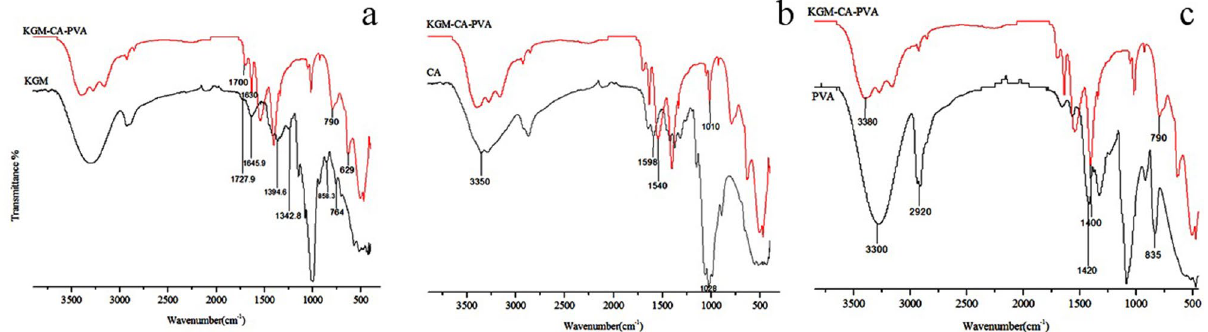
Figure 2. IR spectra of KGM/CA/PVA, KGM, CA and PVA.